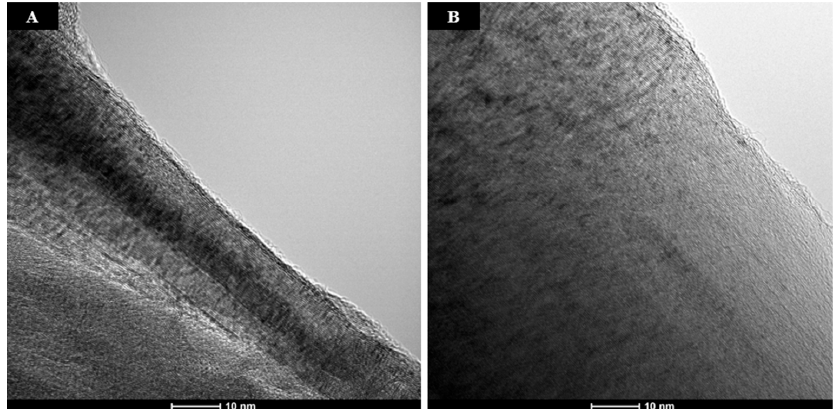
Figure A3. ( A ) TEM micrographs of anthracene coke after 1 min ( B ) and 5 min at 2600 °C.